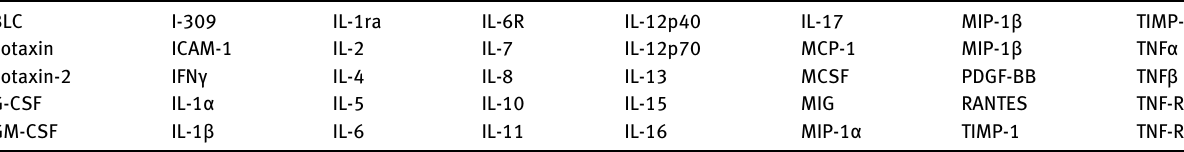
Table  :  cytokines detected for anal fi stula with chronic diarrhea, chronic diarrhea only and healthy control groups.